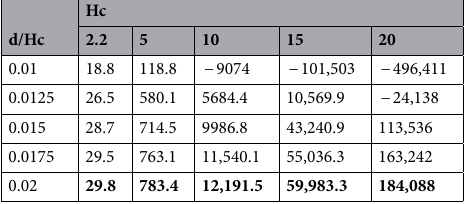
Table 5. Interaction effect of d Hc. Significant values are in bold.